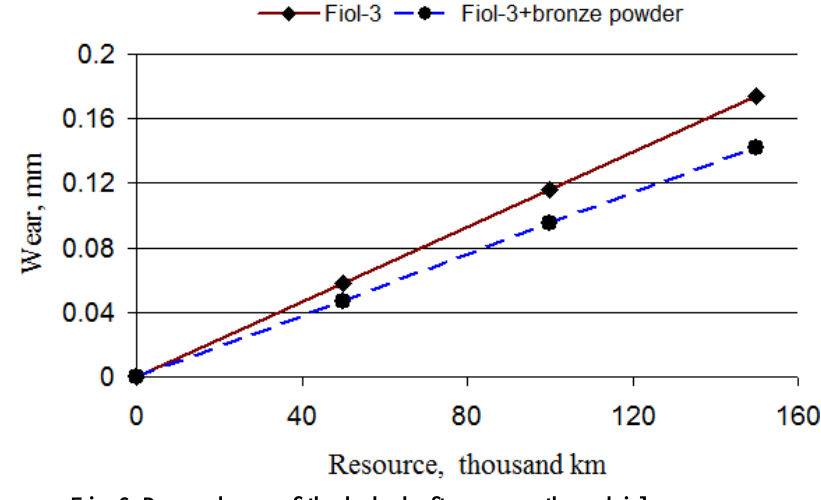
Fig. 6. Dependence of the hub shaft wear on the vehicle